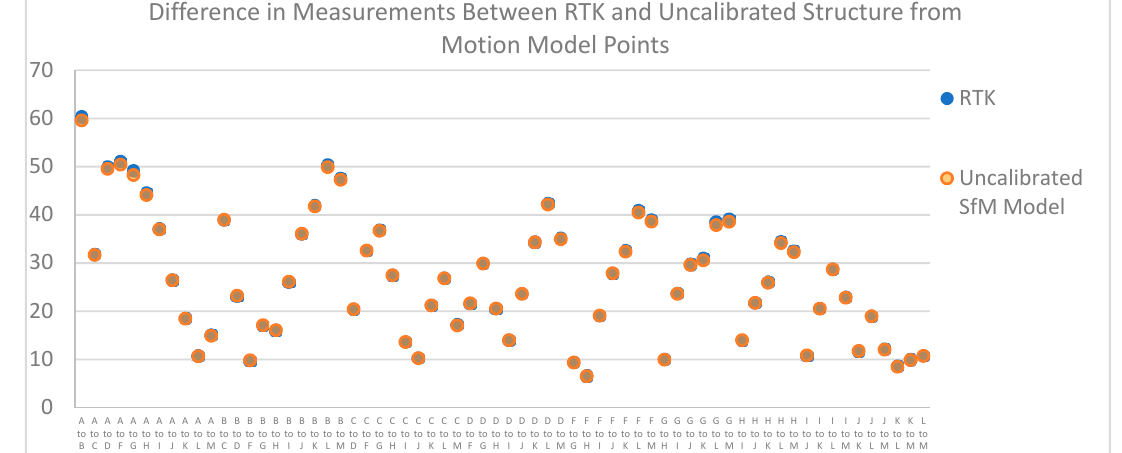
Figure A1. This scatter plot illustrates the difference between the RTK calculated distances and distances calculated with the uncalibrated SfM model. Distances are in meters.